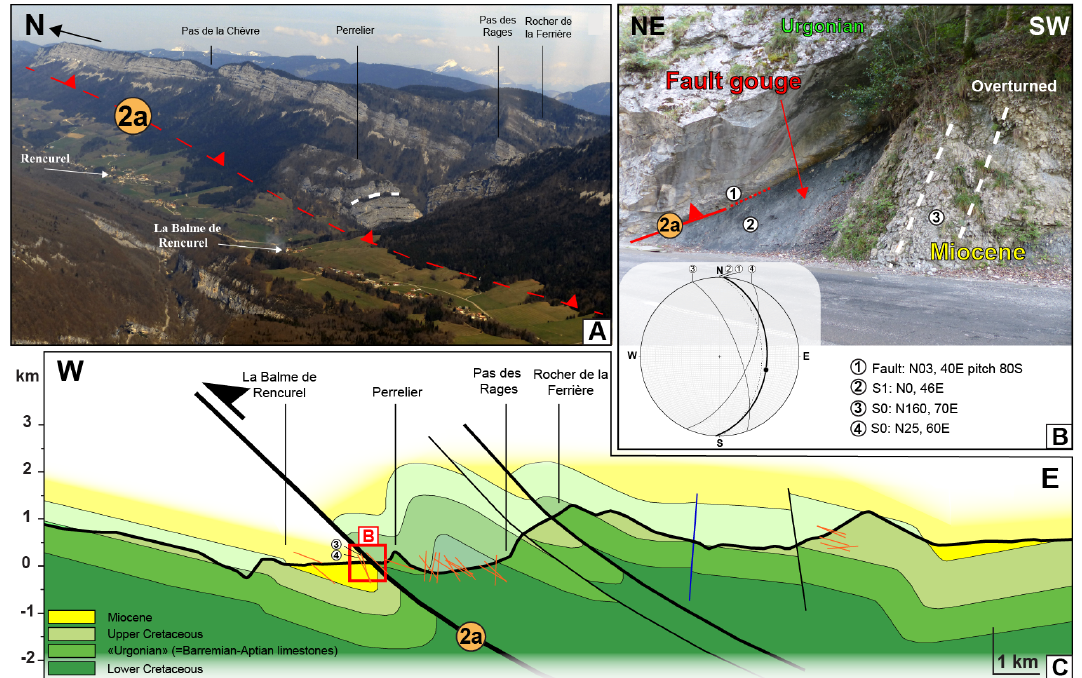
Figure 8. The Rencurel thrust in the Vercors massif. (A) The N–S Rencurel thrust that juxtaposes Cretaceous units on top of Miocene molasse deposits. View from the southwest. (B) Outcrop of the Rencurel thrust along the D103 road, SE to the La Balme–Rencurel village, exhibiting Barremian–Aptian limestones thrust on top of overturned Miocene deposits. Corresponding sterographic diagram (lower hemisphere) at the bottom. (C) E–W cross section along the “gorges de la Bourne”. Orange lines: projected dip measurements. Blue line: right-lateral strike-slip fault. Black line: thrust. See Fig. 7A for the location of the cross section and dip measures in map